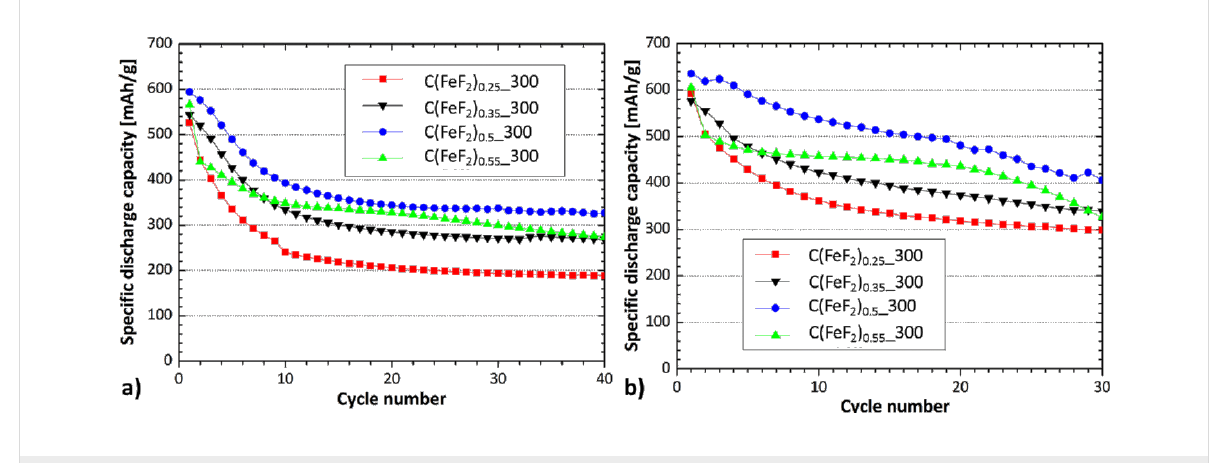
Figure 7: Discharge capacities at: a) 25 °C, b) 40 °C. The samples were cycled with a current density of 25 mA/g.